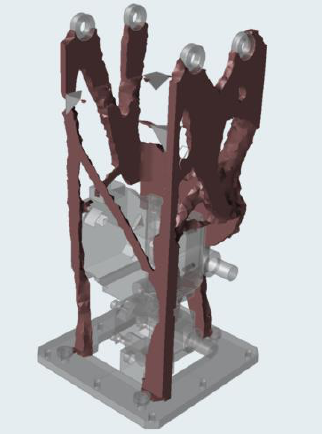
Figure 8. Material density distribution after topology optimization.